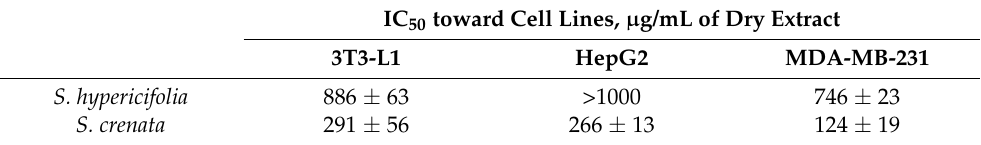
Table 3. Cytotoxic activity of water-ethanol extracts from aerial parts of S. hypericifolia and S. crenata . IC 50 toward Cell Lines, µ g/mL of Dry Extract 3T3-L1 HepG2